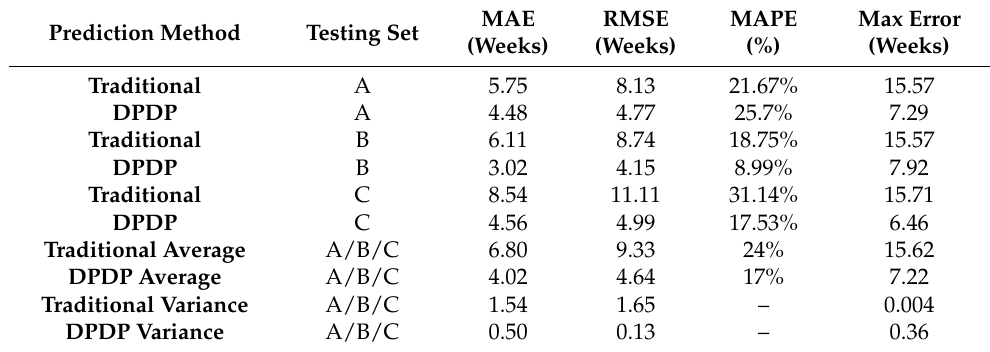
Table 4. Comparing Organization 2’s traditional vs. DPDP prediction accuracy.